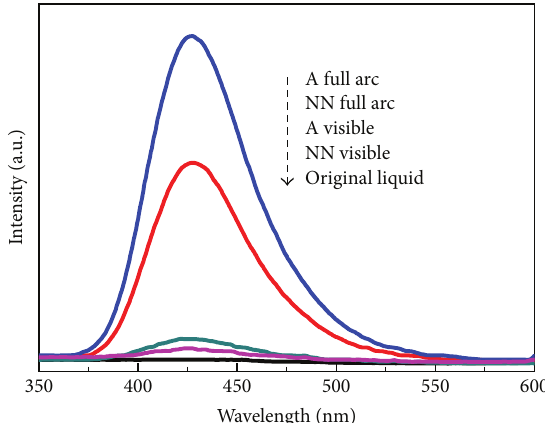
Figure 7: Fluorescence spectra of 2-hydroxyterephthalic acid (TAOH) over NN and A after 1h of full arc and visible light irradiation of Xe lamp.